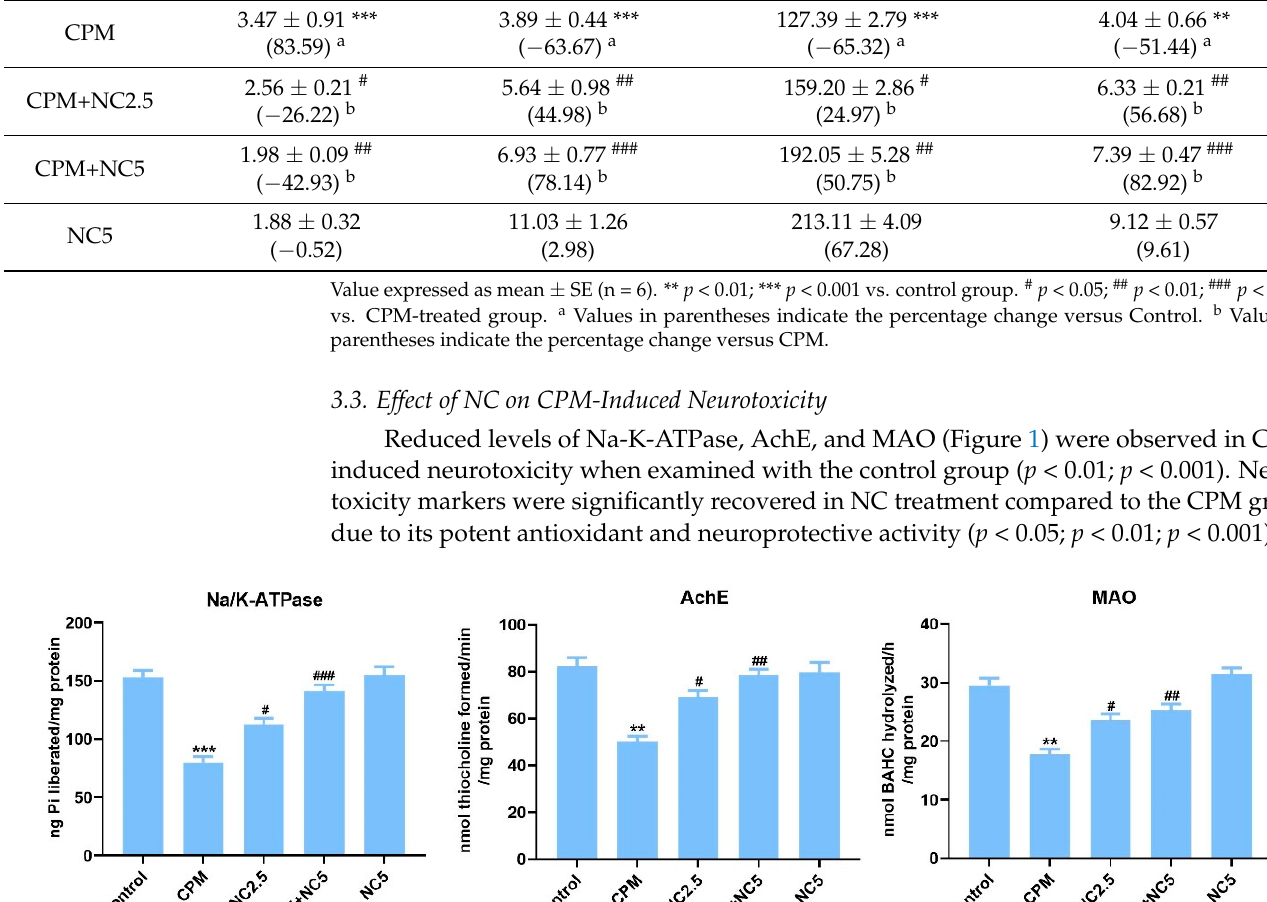
Table 2. Effect of NC treatment on CPM-induced brain stress.